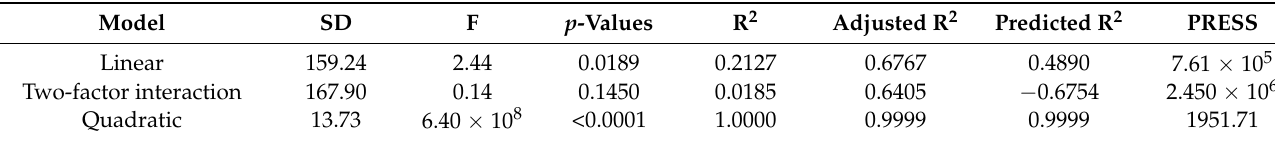
Table 2. Statistical data of the polynomial